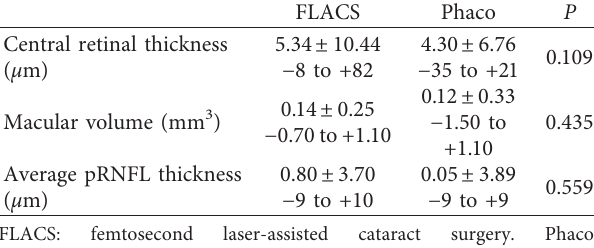
FLACS: femtosecond